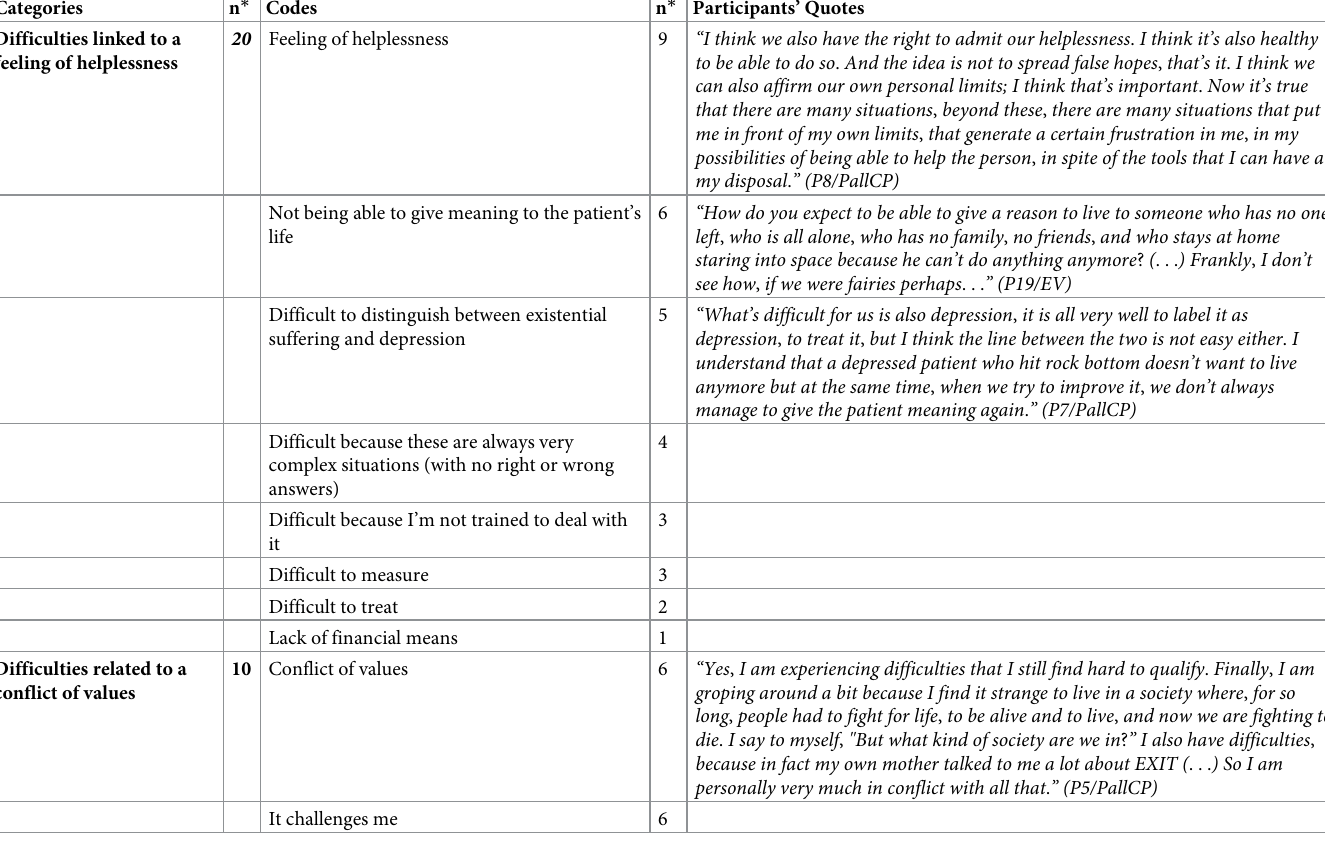
Table 2. Difficulties encountered when facing existential suffering in AS